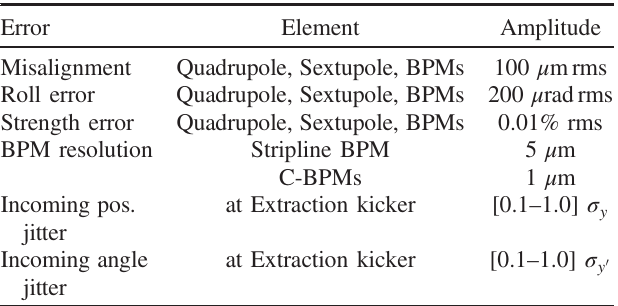
TABLE III. Summary of static and dynamic imperfections, BPM resolutions, and incoming beam jitters assumed in simu- lations of beam transport in the ATF2 beam